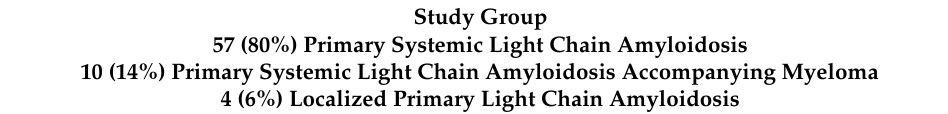
Table 2. Characteristics of the study